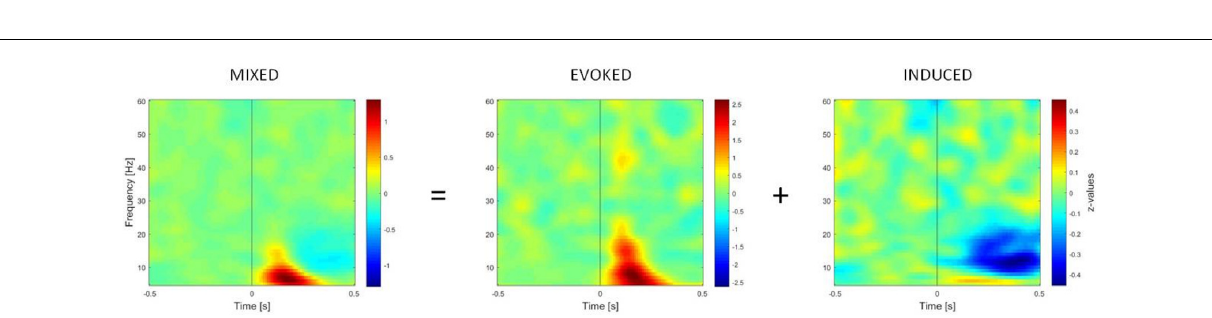
sum of the t -values within every cluster. Comparisons were performed for the maximum values of summed t -values. Using a permutation test (i.e., randomizing data across conditions